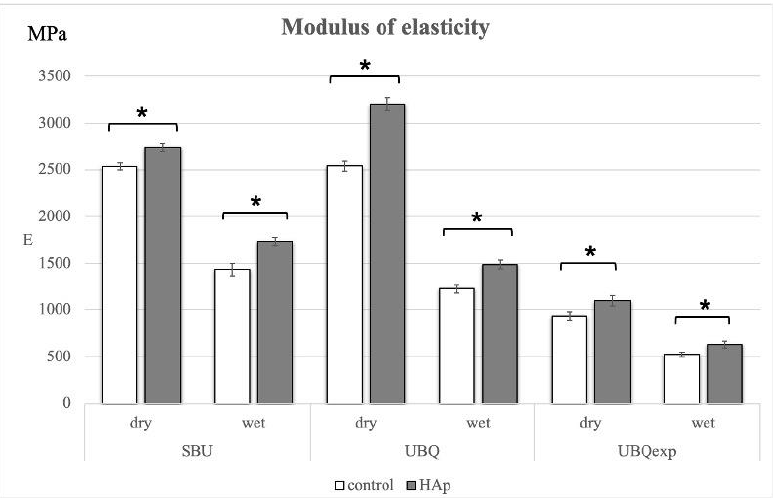
Figure 3. Values of the modulus of elasticity of the commercial 1-SEAs Scotch Bond Universal (SBU), Universal Bond Quick (UBQ), and Experimental 1-SEA (UBQ exp ). Asterisks show significant differences ( p < 0.05) ( n = 8).